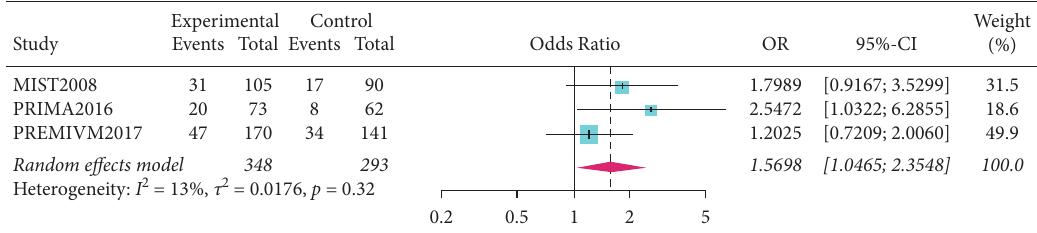
Figure 2: Forest plot for 50% reduction in monthly migraine attacks and monthly migraine days.